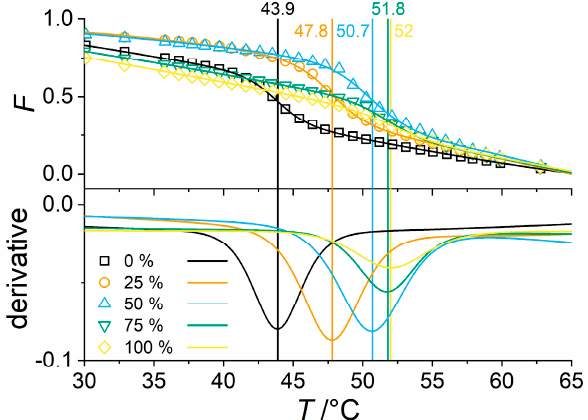
Figure 6. ( Top ) Dependence of the normalized wavenumber of the N-D-vibration on the temperature for five D7-pNIPMAM-H-pNIPMAM co-polymers with 0, 25, 50, 75, and 100% D7-pNIPMAM measured by FTIR spectroscopy in heavy water. A representative temperature-dependent FTIR spectroscopy measurement is shown in the SI in Figure S4. ( Bottom ) Derivative of the fit in the upper part of the graph. The vertical lines indicate the VPTT.